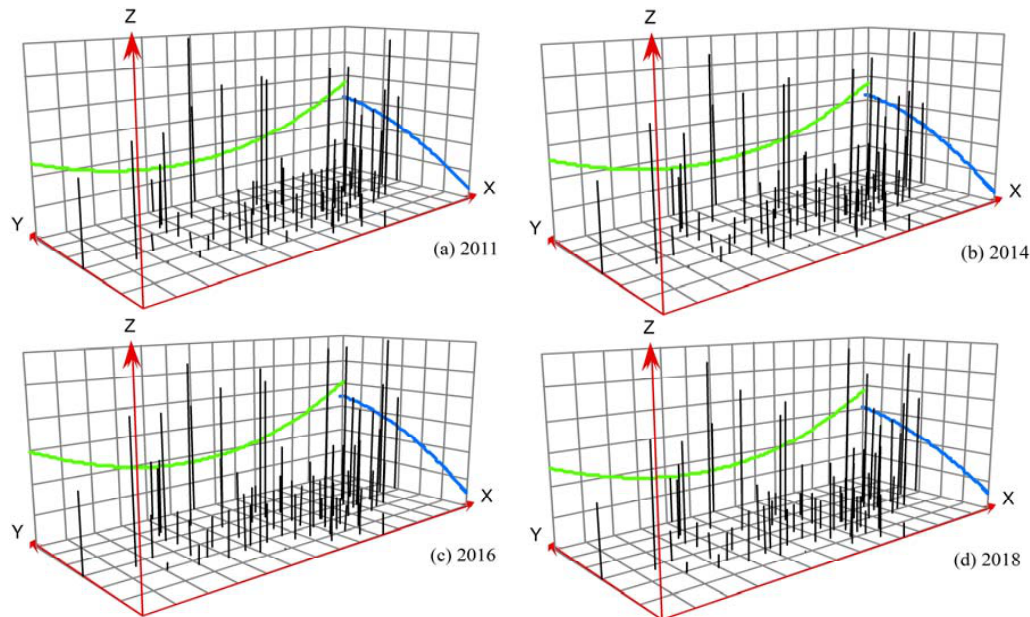
Figure 4. The evolution trend of URI in the YRB.